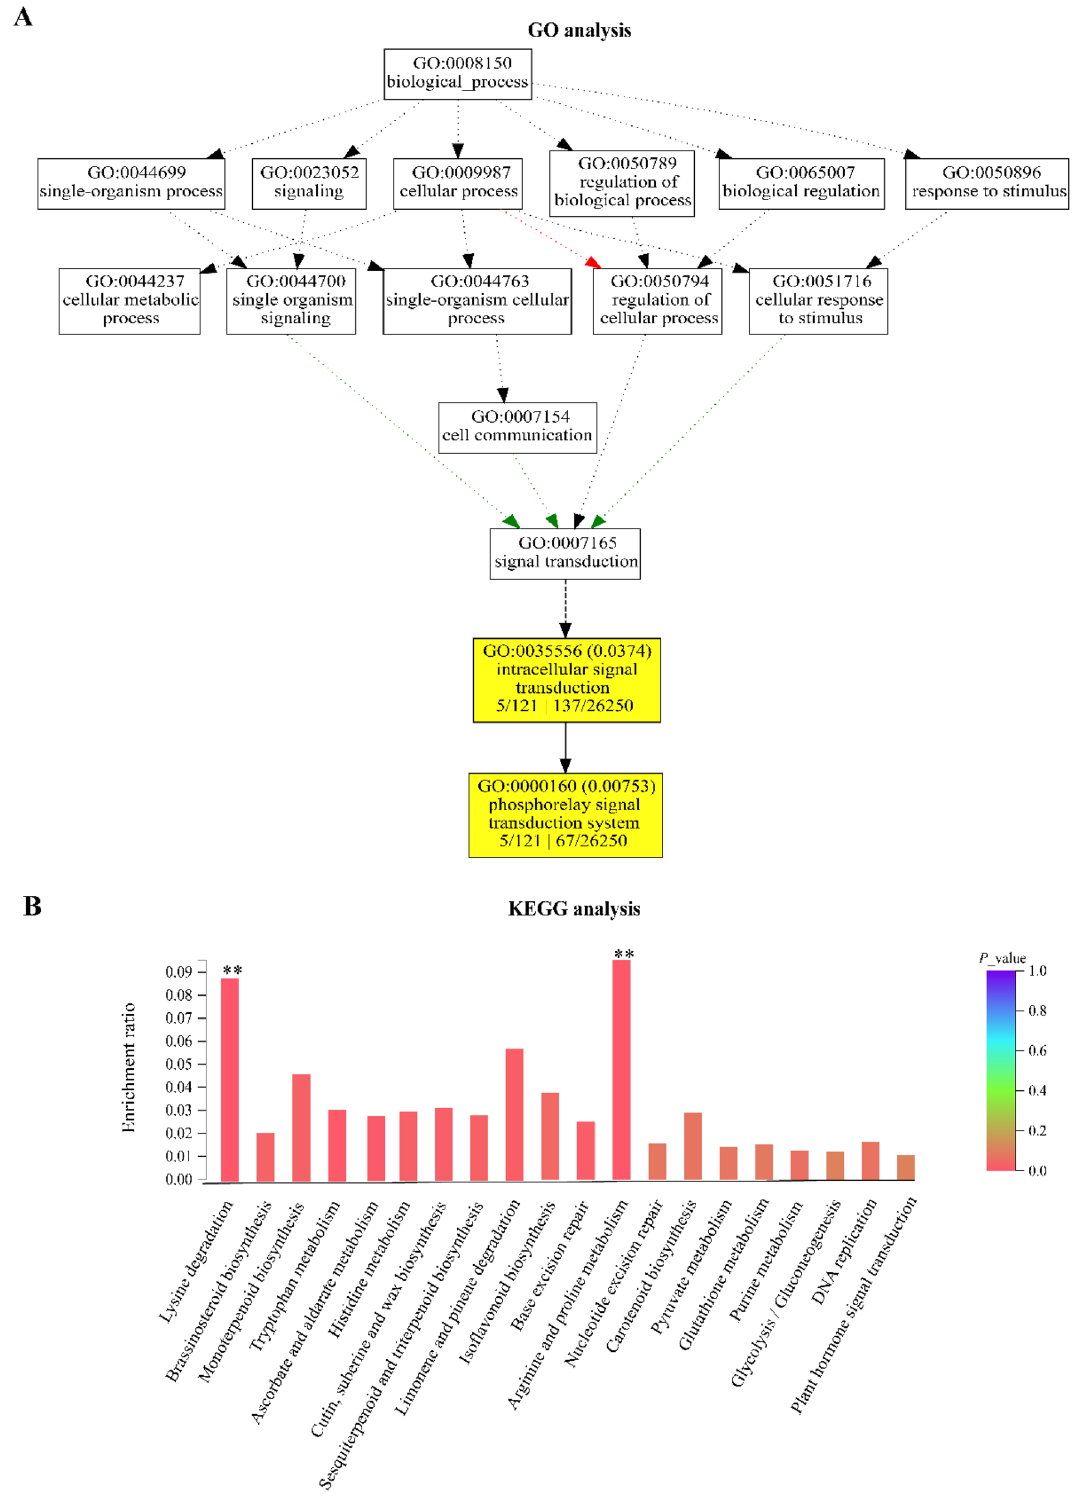
Figure 7. Bioinformatic analysis on different abundant genes in maize grown in Harbin compared to Zhengzhou. The abundance of genes derived from the average across CK and two transgenic events in GM-ZD958 maize lines. ( A ) Gene Ontology (GO) analysis on different abundant genes (DAGs) in maize grown in Harbin compared to Zhengzhou. Enriched biological pathway were highlighted in yellow. ( B ) Kyoto Encyclopedia of Genes and Genomes (KEGG) analysis on DAGs in maize grown in Harbin compared to Zhengzhou. Significantly enriched metabolic pathways were shown symbol “*” and “**”, as indicated P value < 0.05 and 0.01,